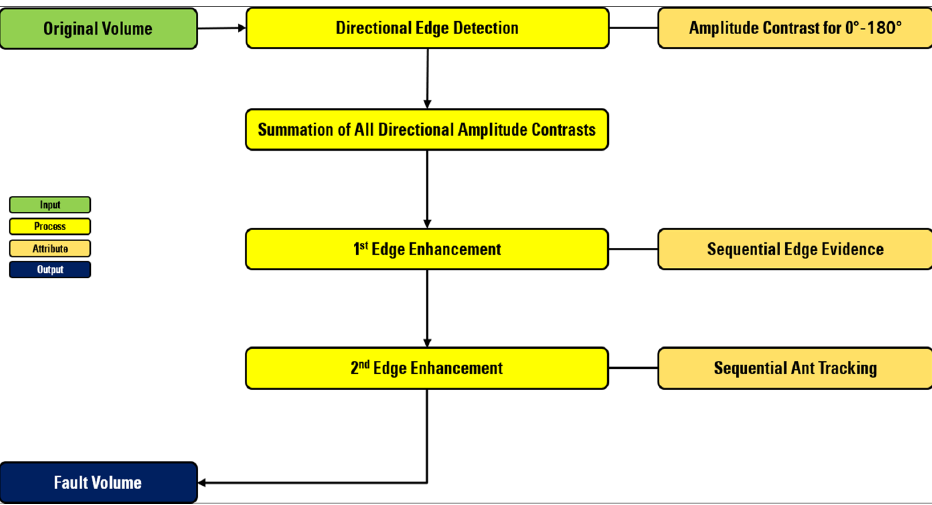
Figure 2. Workflow proposed in this study for fault detection consists of directional edge detection, summation, and edge enhancement. The workflow is significantly simplified, and the computational time is also reduced due to the application of reduced attributes.